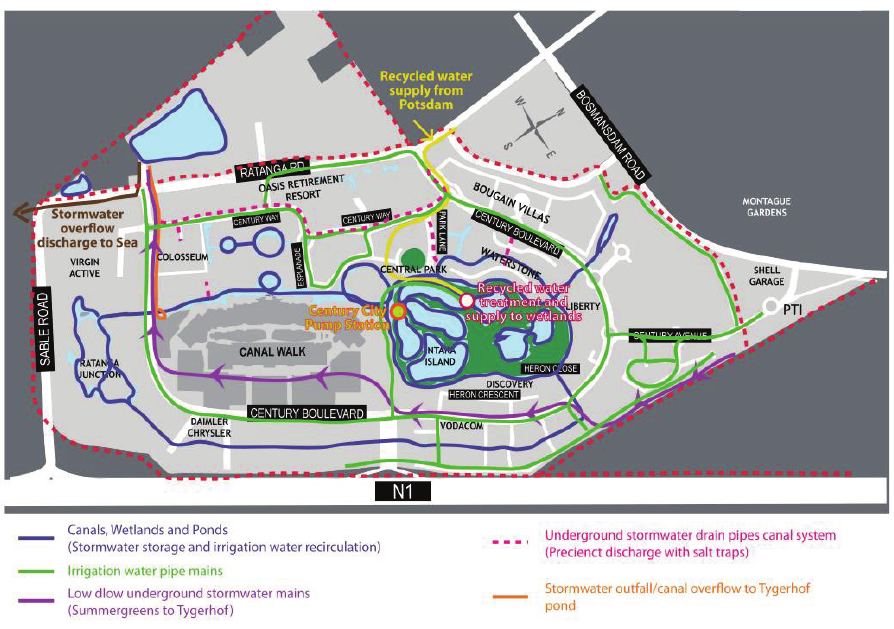
Figure 11: Water supply in City of Cape